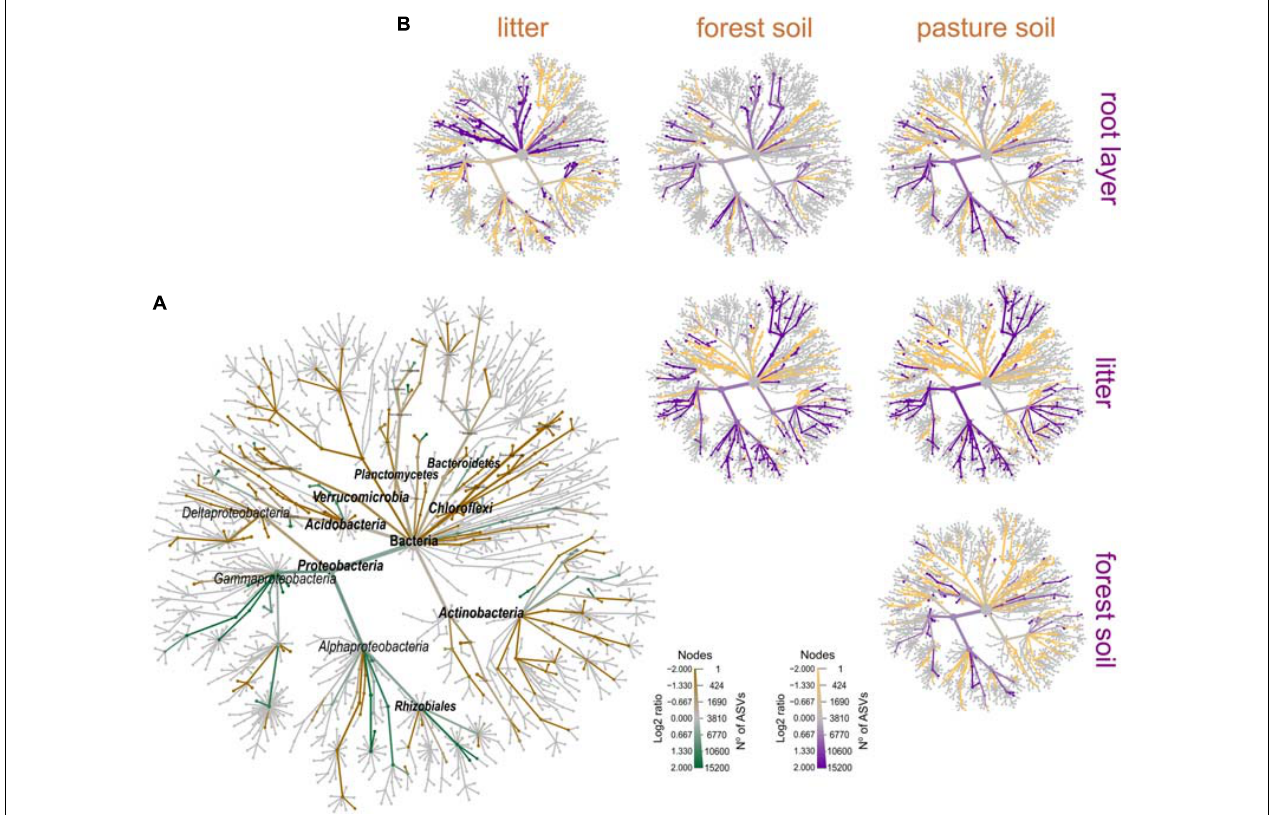
FIGURE 5 | Phylogenetic differential heat tree highlighting the most expressive features among the compartments of the forest floor. (A) Predominance of phylogenetic groups in the forest floor (green color) and pasture bulk soil (brown color); (B) pairwise comparison between each compartment; the color of each branch represents the log-10 ratio of median proportions of reads observed at each compartment. Only significant differences are colored, determined using a Wilcox rank-sum test followed by a Benjamini–Hochberg (FDR) correction for multiple